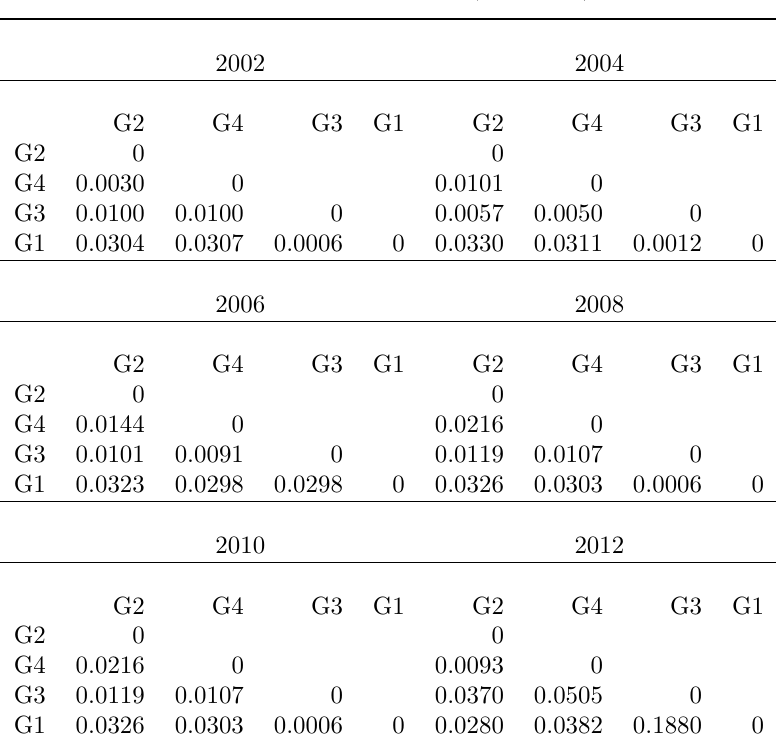
Not inequality among groups